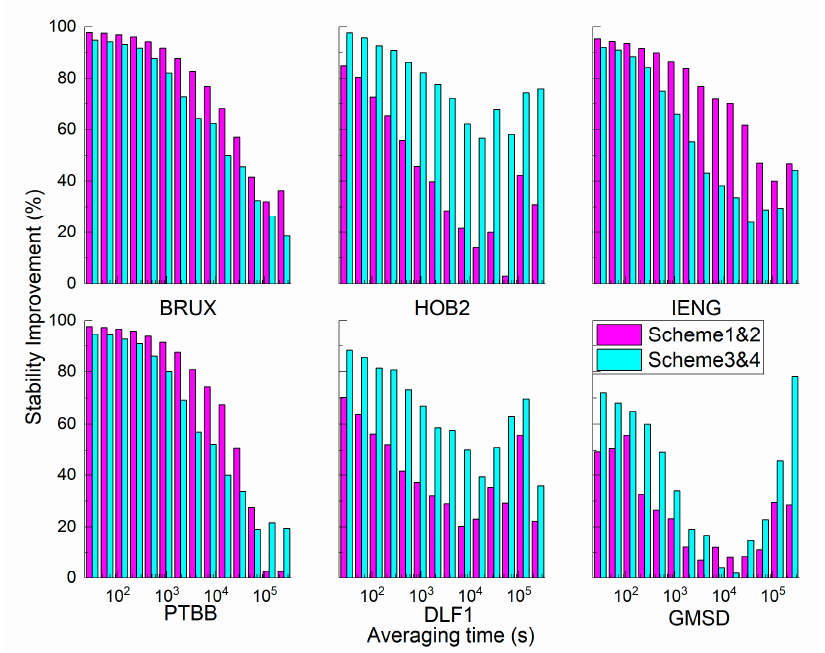
Figure 11. Comparison on modified deviation of six stations.